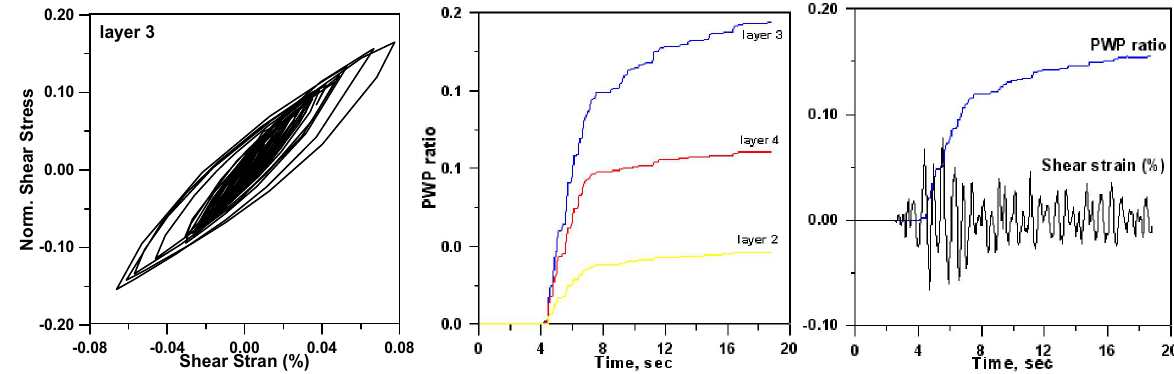
Fig. 30. Stress-strain history (a) for the layer with high probability to liquefy; PWP time histories at different ground level (b) ; PWP and shear strain time histories (c) for the layer with high probability to